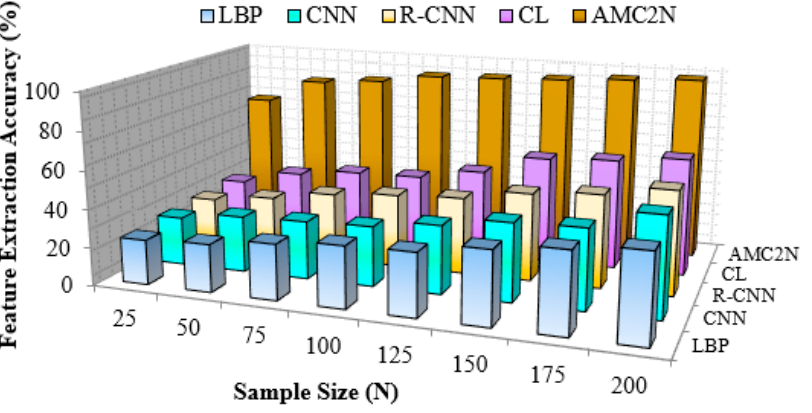
Figure 9. Comparison of feature extraction accuracy (Scenario 2).